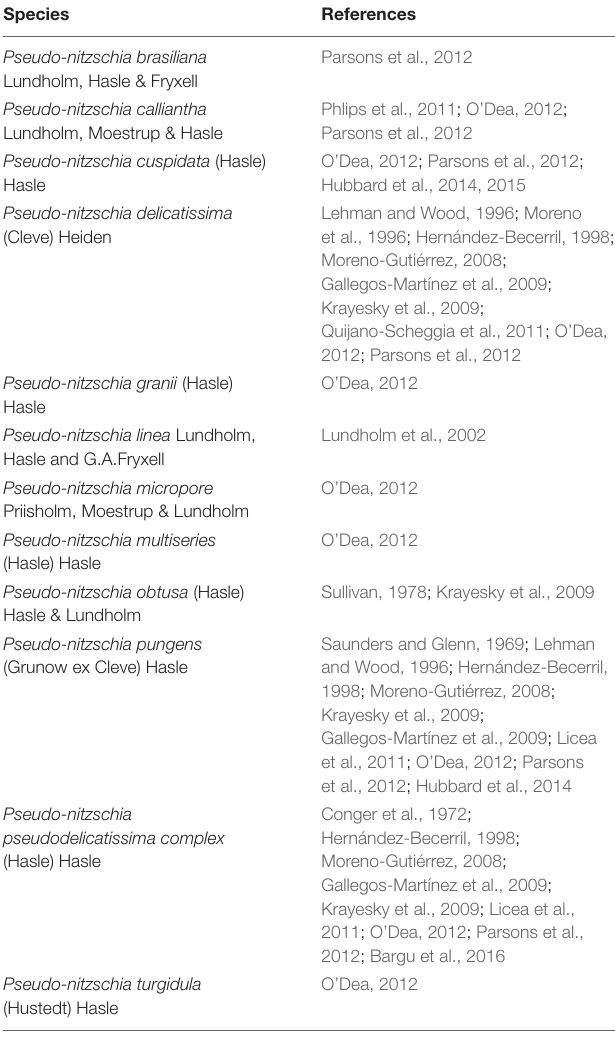
TABLE 3 | Toxic Pseudo-nitzschia species reported from Florida estuarine, coastal and marine waters.